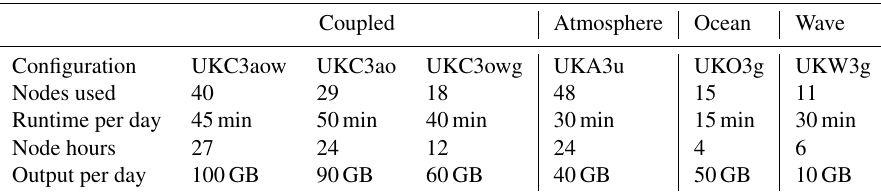
Figure 10. (a, c, e, g) Time series of average model–observation (MODEL–OBS) bias of surface temperature across all observing sites for each simulation for July, April, October 2014 and February 2015, respectively. (b, d, f, h) Differences in absolute | MODEL–OBS | bias for each simulation period relative to UKA3u. A negative relative | average bias | indicates the coupled system to have a lower average absolute bias across all observation sites than the control. Note that plots have different scales across the different months evaluated, and observations are compared with a nearest neighbourhood mean of 3 by 3 model grid cells. Table 11. Summary of computer resource usage and typical runtimes and volume of data outputs generated for each day of simulation of UKC3 systems. Note further optimizations of system node usage and runtimes are